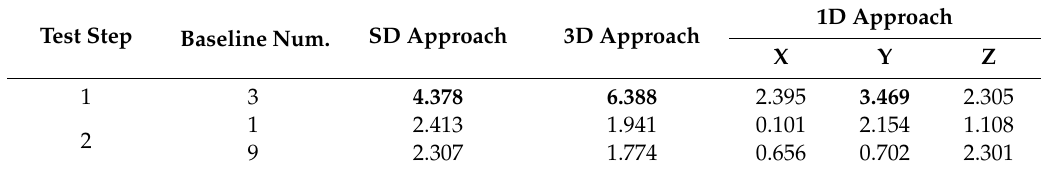
Table 3. Largest test statistics in each outlier detection